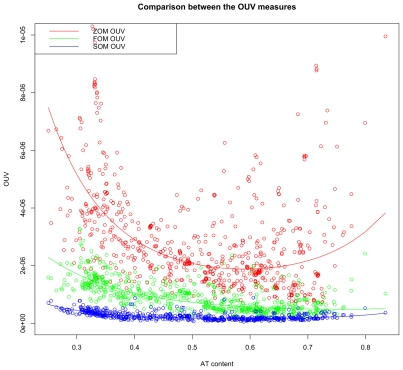
Overview of Markov model based oligonucleotide approximations in prokaryotes.OUV scores based on 0th, 1st and 2nd order Markov models (ZOM, FOM, and SOM respectively) are found on the vertical axis. Each chromosome is sorted with respect to increasing AT content from left to right along the horizontal axis. ZOMs (red line) approximate genomic tetranucleotide usage with nucleotide frequencies, while FOMs (green line) use genomic dinucleotide content in addition. The 2nd order Markov model (blue line) bases tetranucleotide frequency approximations on genomic di- and trinucleotide usage. Larger OUV values mean poorer approximations which is a consequence of more biased tetranucleotide usage.